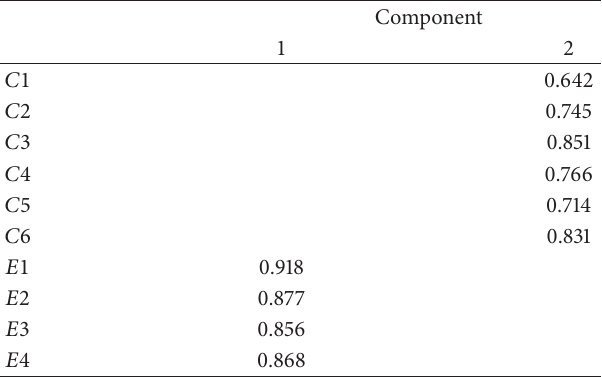
Table 4: The factors extracted via principal component analysis and rotated via